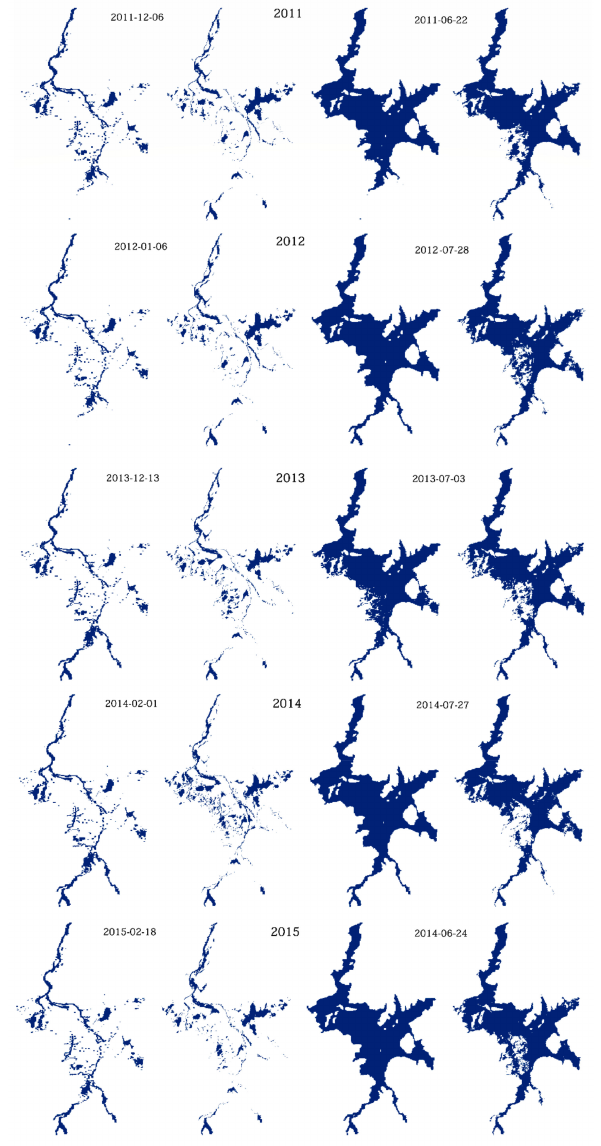
Figure 6. Comparison of the maximum and minimum inundated areas of the model results (left of the date) and those derived from Moderate Resolution Imaging Spectroradiometer (MODIS) images (right of the